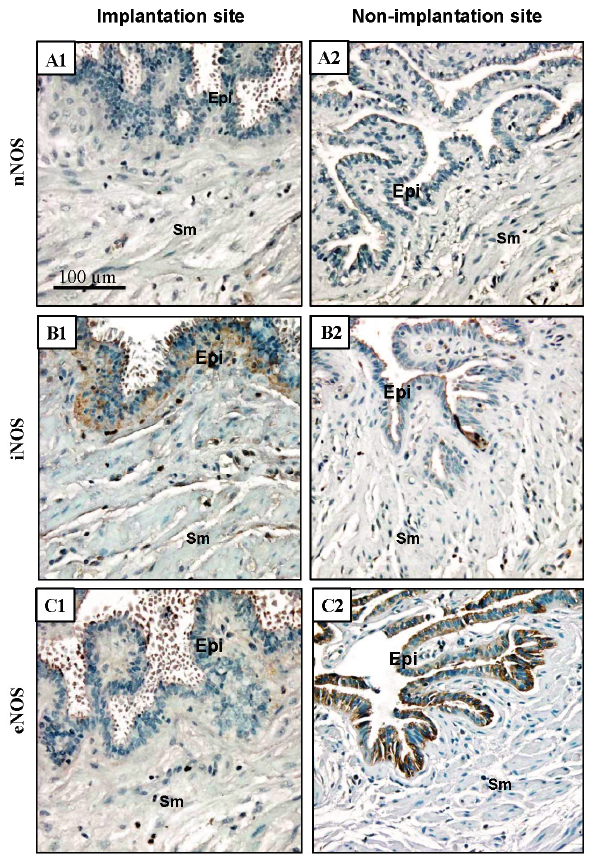
Figure 7. NOS expression in the human Fallopian tube during ectopic